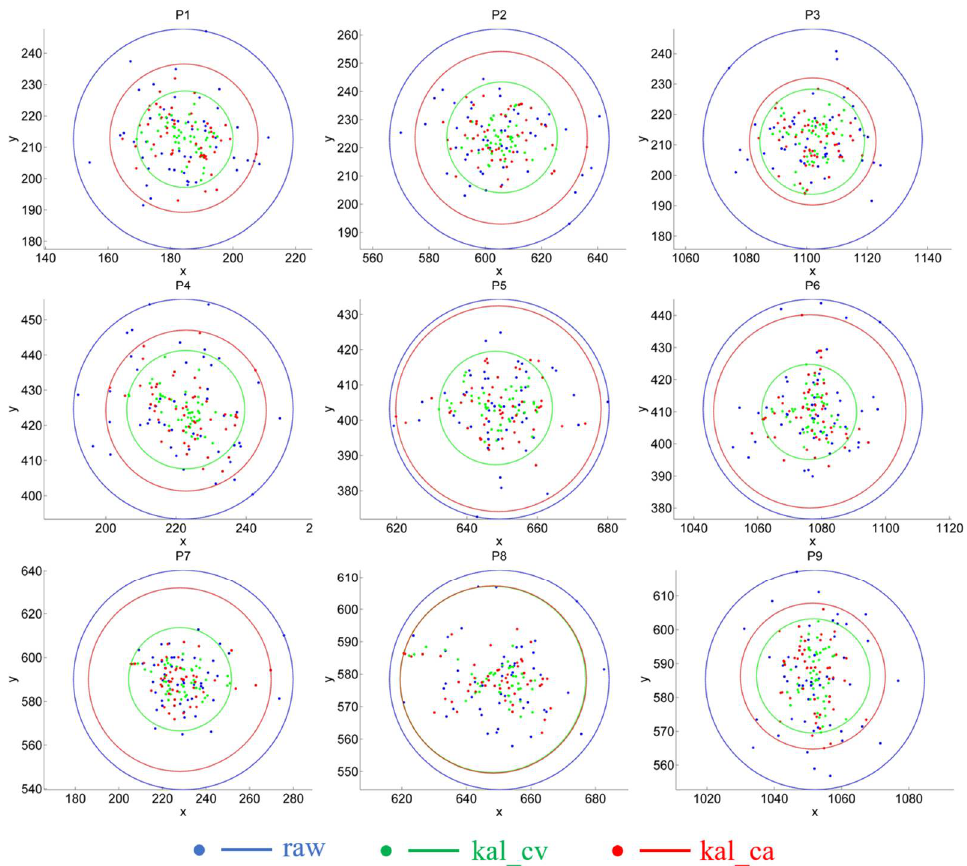
Figure 9. POR estimation of nine calibration points. (p1) to (p9) are the POR estimation results of points P1 to P9, respectively. The blue, green, and red points are the estimated PORs without filtering, with constant velocity model and with constant acceleration model respectively. The circles show the range of the PORs.